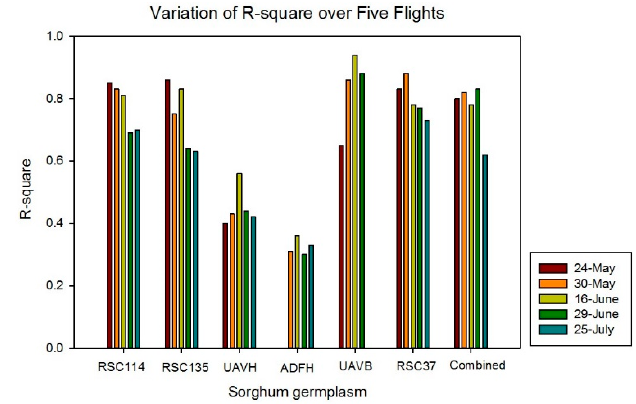
Figure 15. Variation of R 2 for sorghum height estimate over five flights.